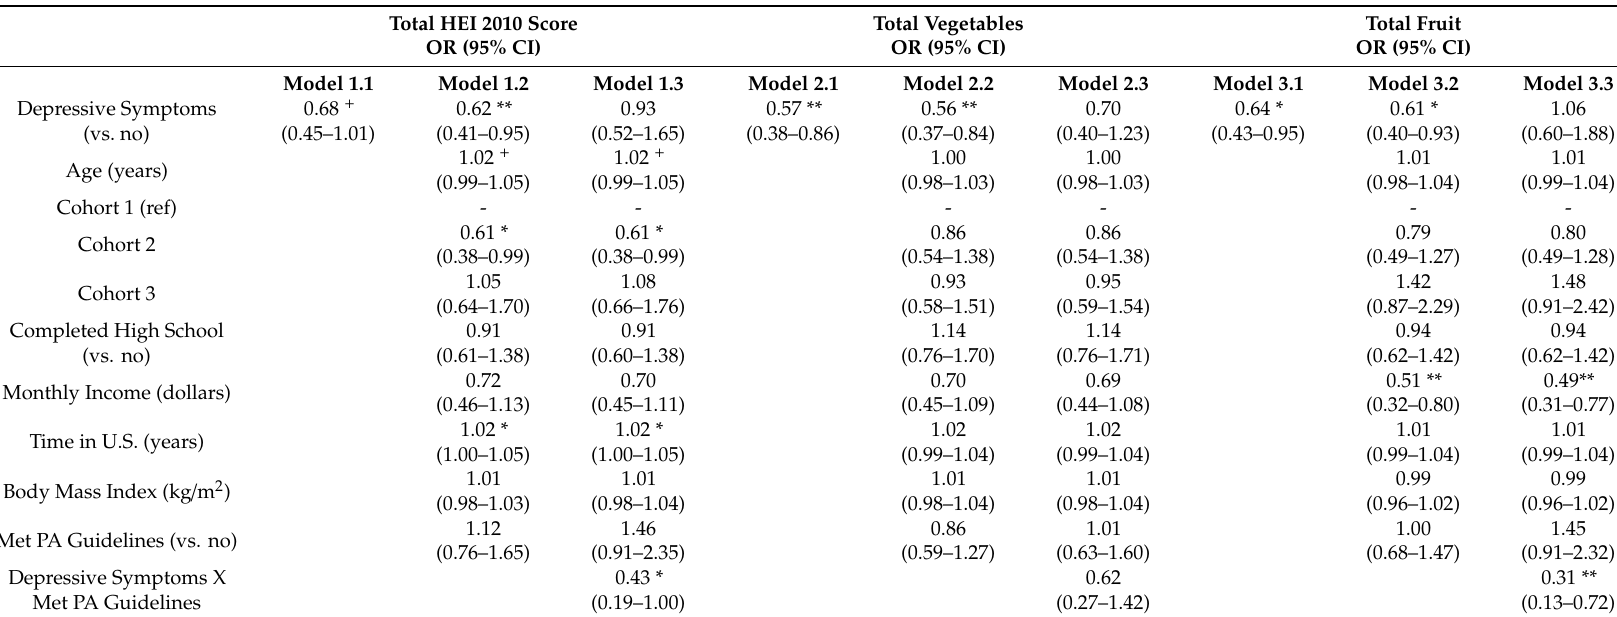
Table 2. Logistic regression models associating higher total HEI 2010 scores and HEI total vegetable and fruit component scores, with depressive symptoms, physical activity, and two-way interaction between depression and physical activity; Enlace (2012–2016; n =